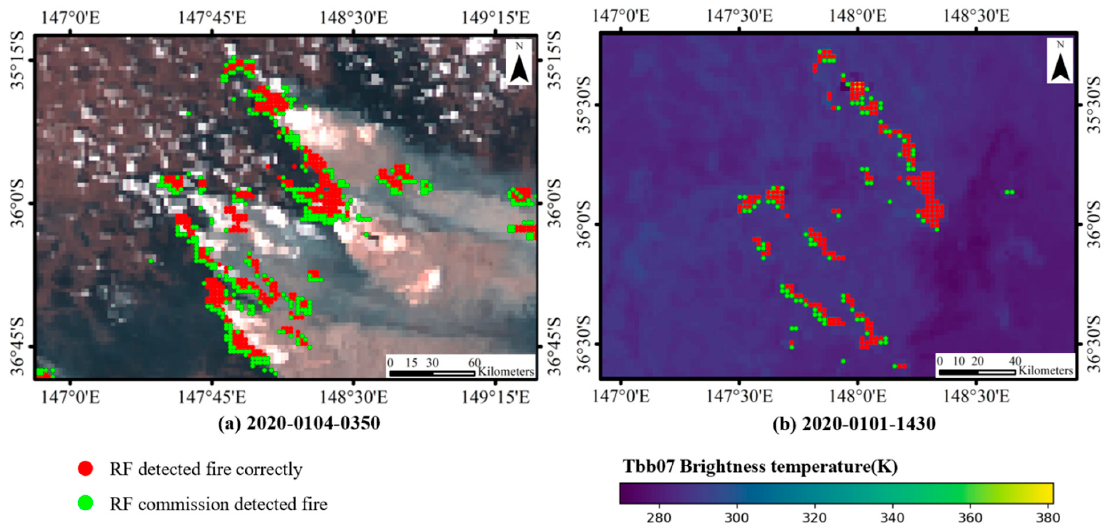
Figure 10. ( a , b ) show the spatial locations of the commission fire pixels in sample area 1 and sample area 3, respectively.